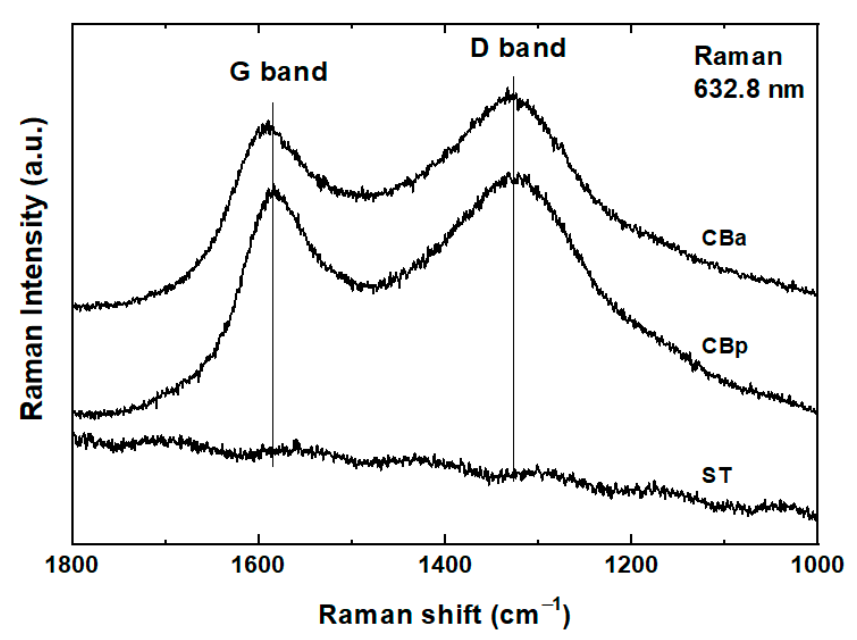
Figure 2. Raman spectra of scrap tyre (ST), pyrolytic carbon black (CBp), and activated carbon black (Cba).